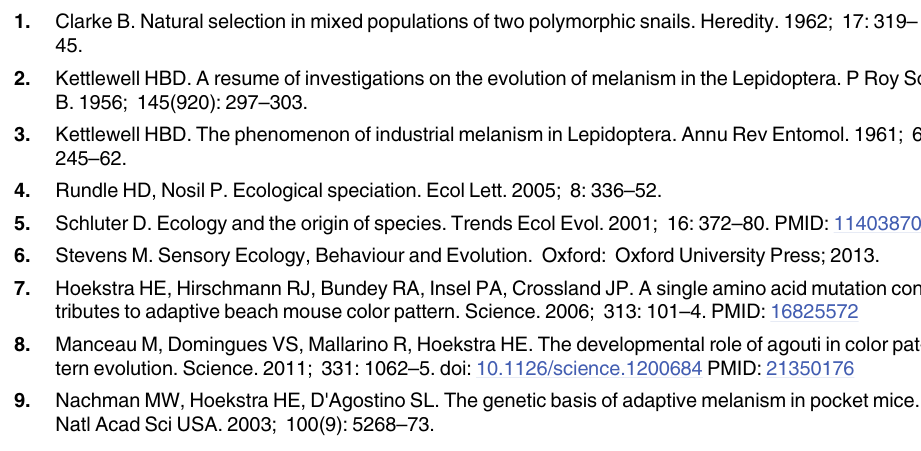
sizes (ETA-squared [ η 2 ]) are shown between island lizard populations (Table A) and between rock backgrounds (Table B) in terms of hue (top row), saturation (middle) and luminance (bot- tom). Figure A shows variation in dorsal coloration ( hue and saturation ) and luminance between the island lizard populations (top row) and their rock backgrounds (bottom row). S2 File. Degree of contrast (JND) between island lizards and between island backgrounds. Occurrence of significant differences and effect sizes (ETA-squared [ η 2 ]) are shown from sta- tistical analyses comparing degree of contrast (JND) between island populations of Aegean wall lizards ( Podarcis erhardii ) and degree of contrast between their rock backgrounds (Table A). Chromatic and luminance JNDs are shown between island lizard populations (Figure A) and between their rock backgrounds (Figure B). S3 File. Island differences in local camouflage. Showing significant differences and effect sizes (ETA-squared [ η 2 ]) comparing degree of local camouflage between different island popu- lations of Aegean wall lizards ( Podarcis erhardii ) (Table A). Degree of dorsal chromatic and luminance camouflage against local and non-local island backgrounds is shown in Figure A. Body region and sex differences in degree of chromatic camouflage (Figure B) and luminance camouflage (Figure C) are shown against local and non-local island